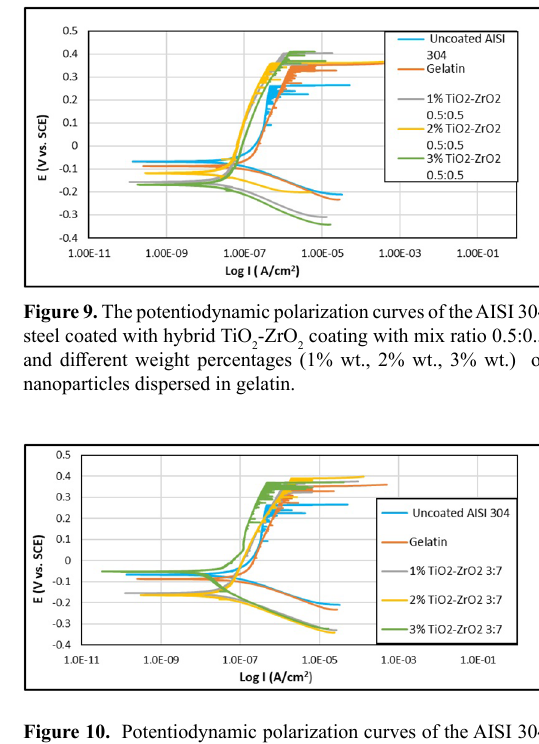
-ZrO coating with mix ratio 0.3:0.7 2 2